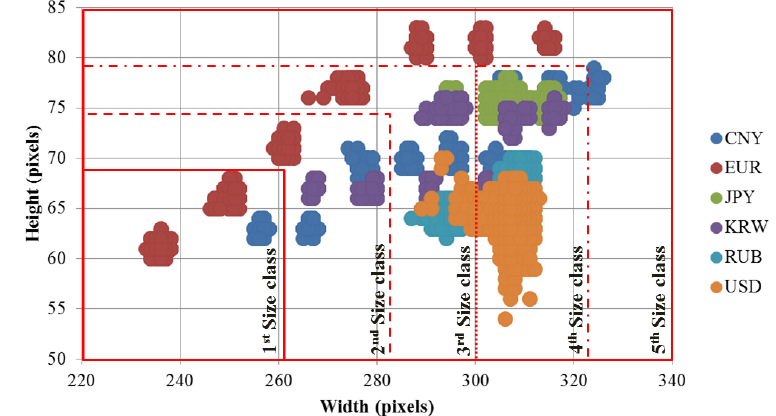
Figure 7. Definition of size classes in ascending order of height and width of banknote. Table 3. Number of images and classes in the experimental multi-national banknote database.